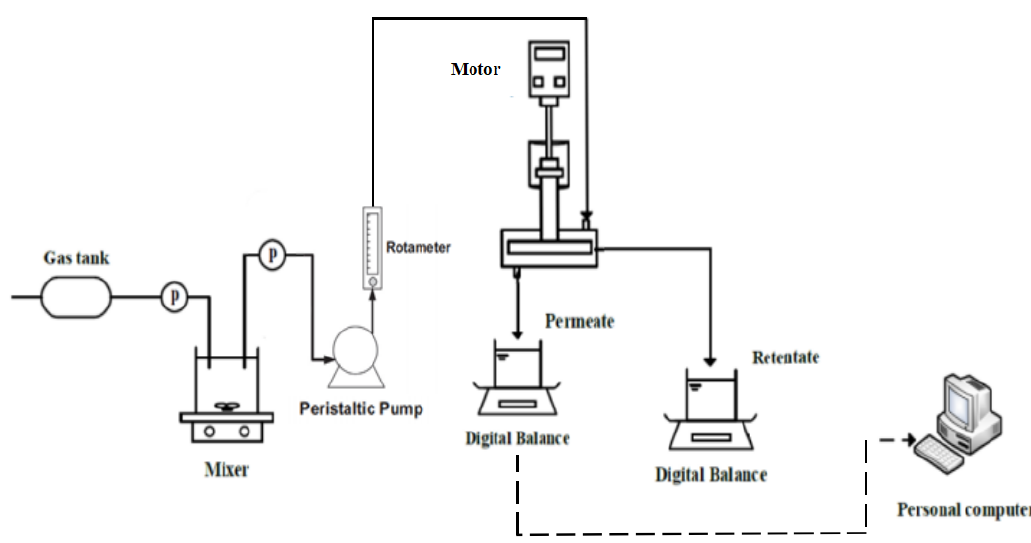
Figure 14. Flow chart of the dynamic cross-flow filtration process.